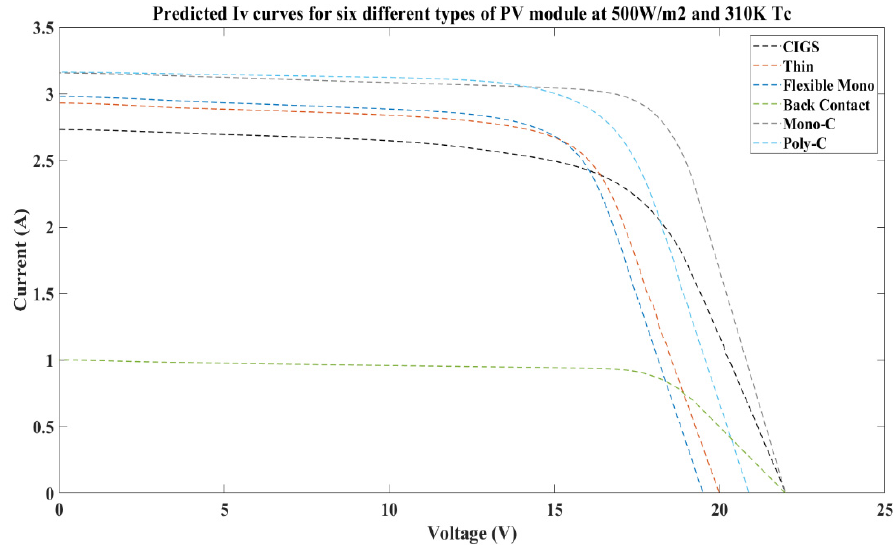
Figure 14. Predicted IV curves for the six PV modules at 500 W/m 2 and 310K Tc.